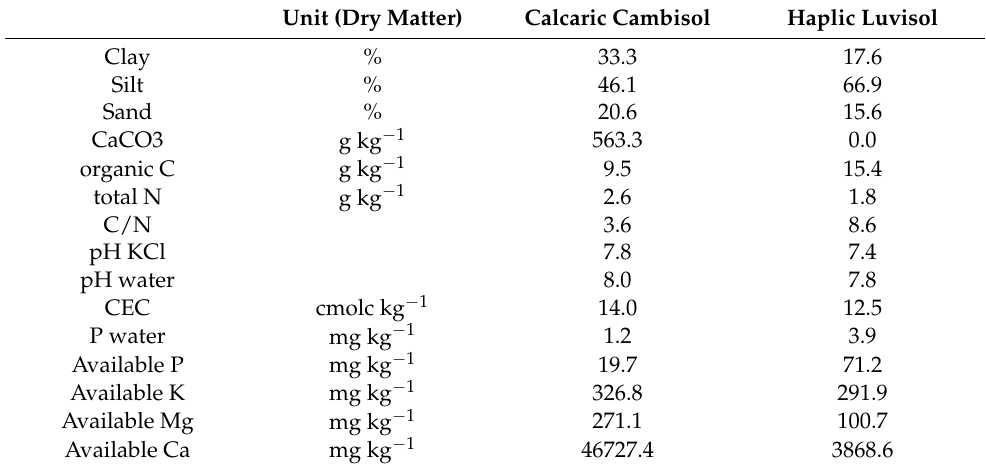
Table 1. Characteristics of the Calcaric Cambisol and Haplic Luvisol used for the pot experiment. Unit (Dry